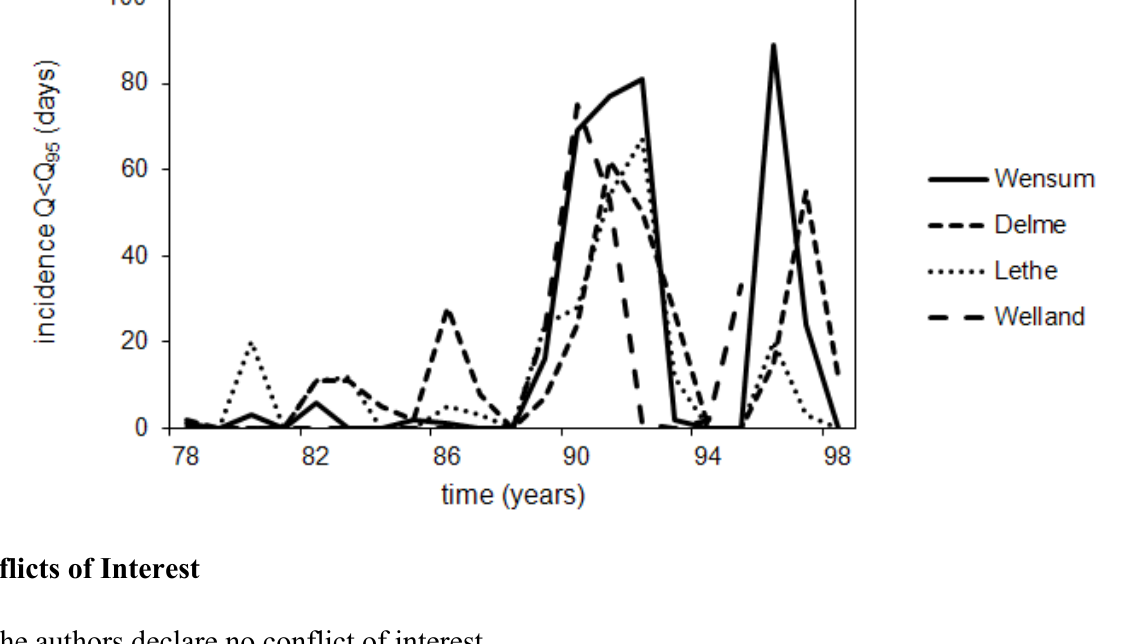
Figure A4. Annual changes in low flow (<Q growth period for the German and English rivers (note no data for Welland